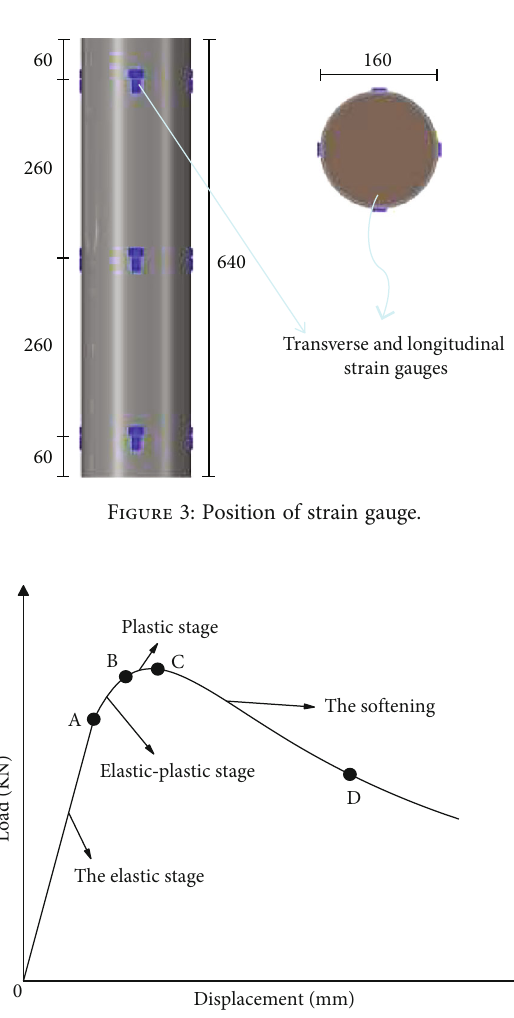
Figure 4: Typical load-displacement